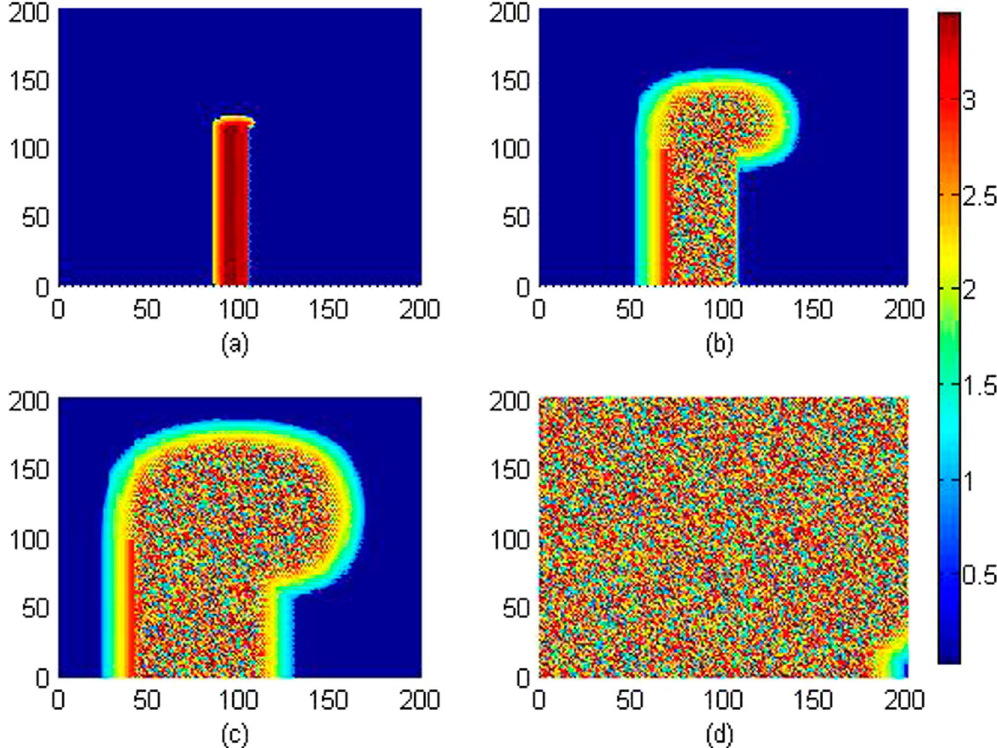
Figure 7. Developed spatial pattern is plotted for the media at t = 10, 60, 100, 200 time units under feedback gain k 2 = 0.15, at k 0 = 0.1, k 1 = 0.5, α = 1, β = 2. The snapshots are shown color scale.